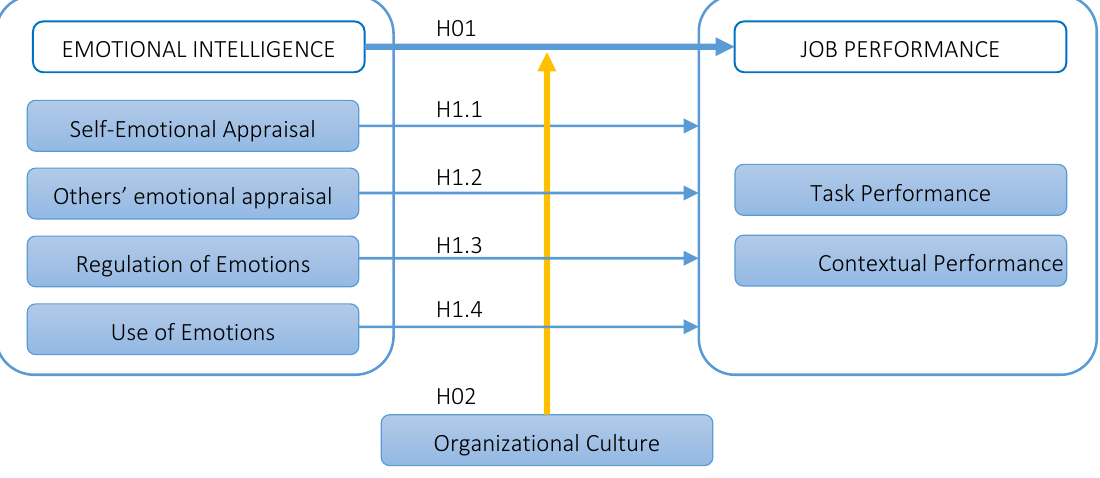
Figure 1. Research